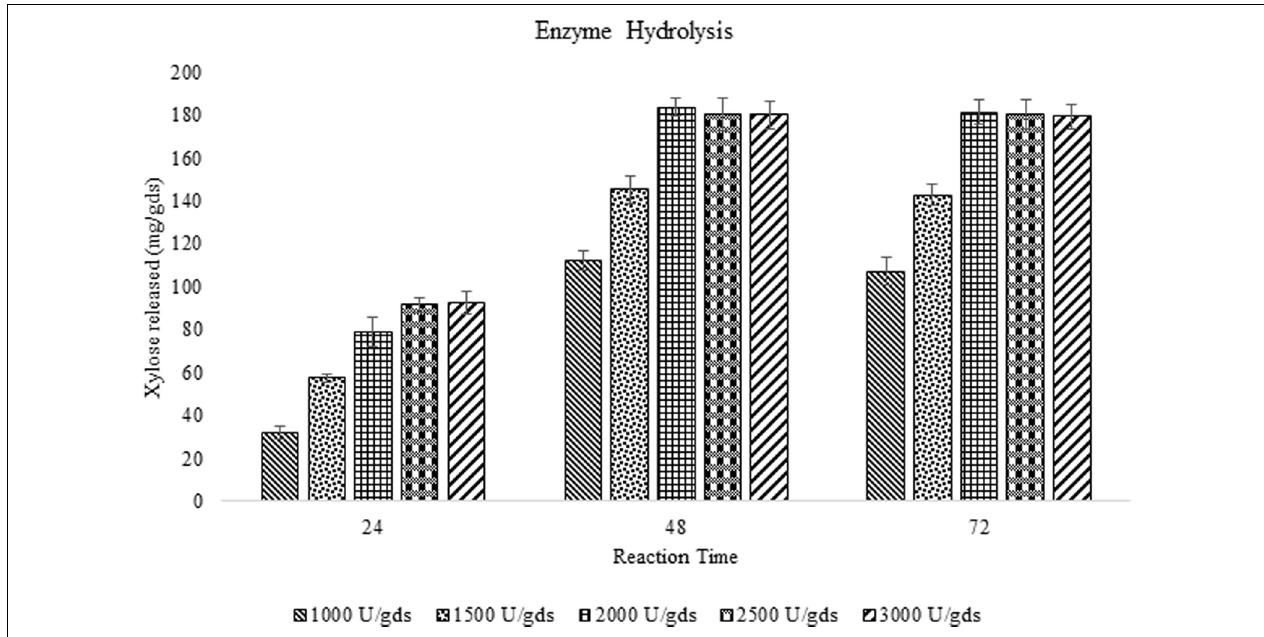
FIGURE 4 | Enzyme saccharification of pretreated corn cob residue and evaluation of efficiency of crude enzyme loads (U/gds) with respect to the yield of fermentable sugars and reaction time (h).